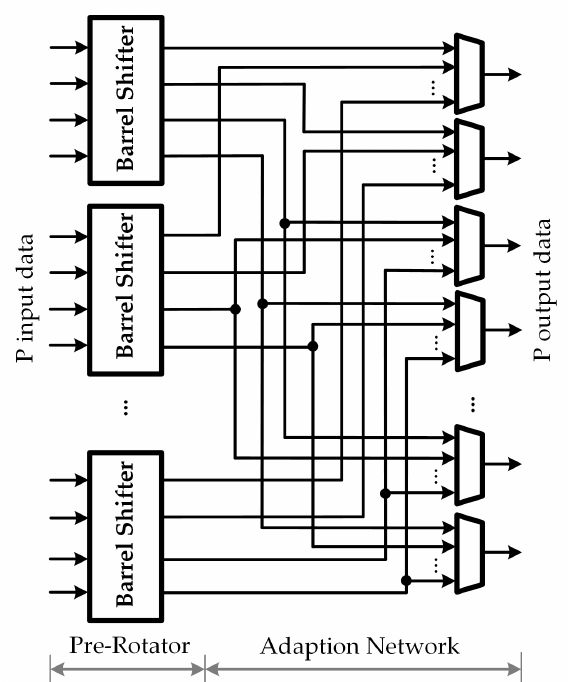
Figure 3. Pre-rotator and MUX network